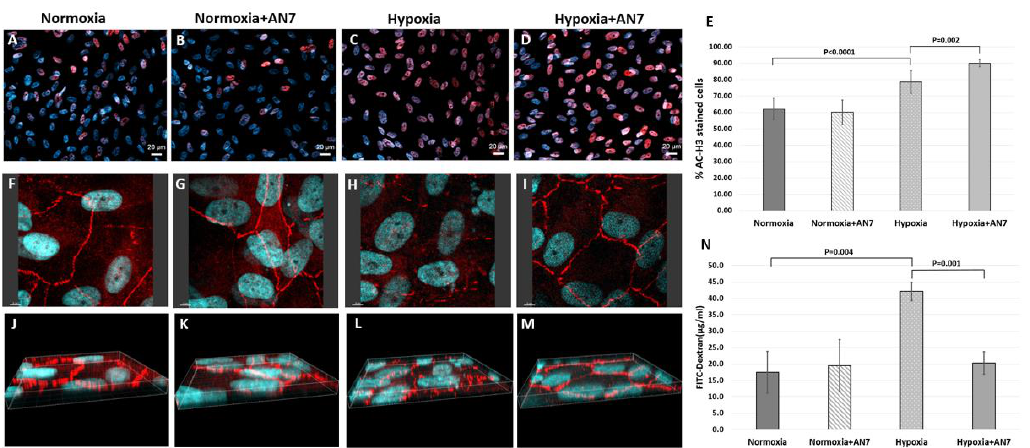
Figure 5. AN7 treatment stabilizes the retinal pigmented epithelium (RPE) monolayer during hypoxia. RPE cells were grown in normoxic or hypoxic conditions for 24 h, in the presence or absence of AN7 in the media. ( A – D ) Representative images of RPE cells stained for acetylated histone H3 (AC-H3; red) and cells nuclei, DAPI (blue). Scale bar, 20 µ m. ( E ) Quantification of the percentage of AC-H3 stained cells of total cells, comparing normoxic and hypoxic conditions in the presence or absence of AN7 in the cell media. One-way ANOVA followed by Tukey’s multiple comparisons test was used for statistical analysis. ( F – M ) Representative images of RPE cells stained for the tight junctions associated protein, Zonula Occludens-1 (ZO-1; red) and cells nuclei, DAPI (blue). Scale bar, 5 µ m. ( E – H ) Z -axis images are showing the distribution pattern of ZO-1 through the borders of the cells. ( N ) Quantification of FITC-dextran leakage through the RPE cell layer grown on Polyethylene Terephthalate (PET) membranes, comparing normoxic and hypoxic conditions in the presence or absence of AN7 in the cell media. One-way ANOVA followed by Tukey’s multiple comparisons test was used for statistical analysis.